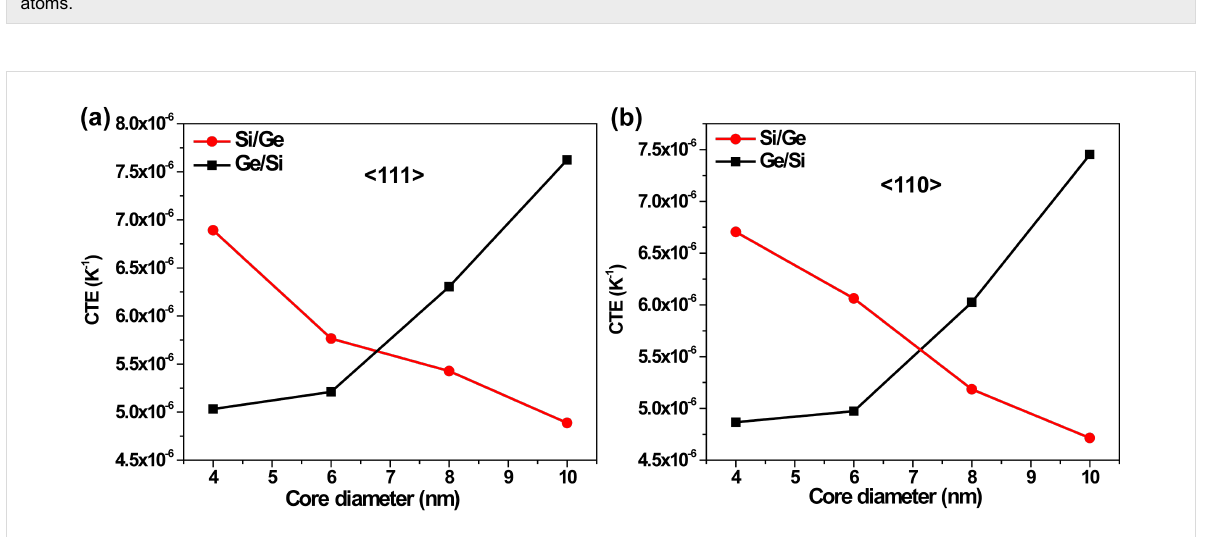
Figure 4: Coefficients of thermal expansion plotted against the core diameter of Si/Ge and Ge/Si CSNWs oriented in (a) <111> and (b) <110> axial